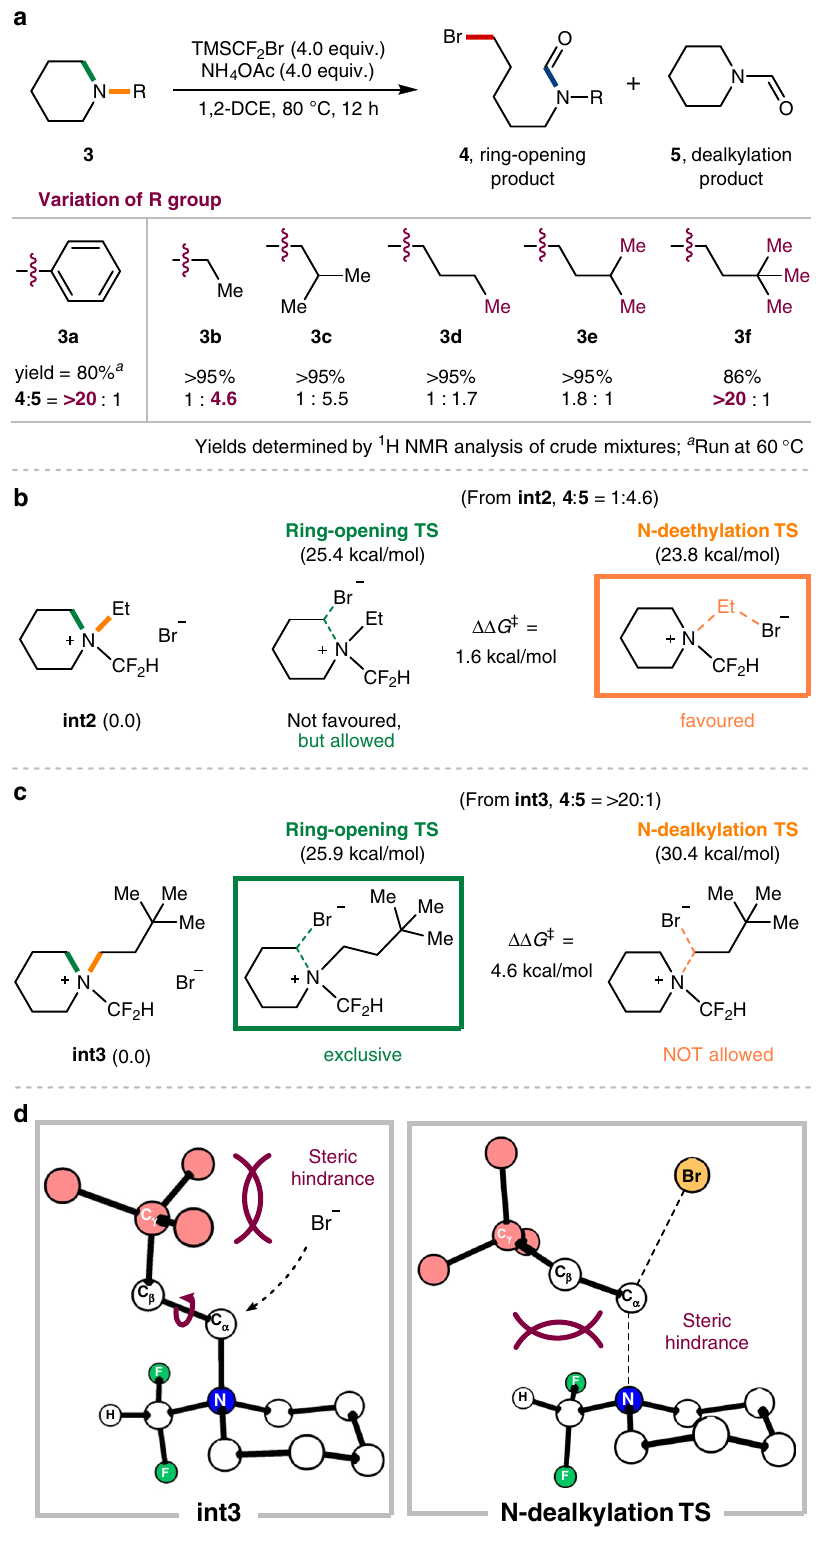
Fig. 5 Application to 6-membered cyclic amines and DFT calculations for the elucidation of the observed selectivity. a In fl uence of R group on the site- selectivity in 6-membered rings. b Competitive reaction energy pro fi les of N -dealkylation and ring-opening pathways of N -ethyl salt int2 . c Competitive reaction energy pro fi les of N -neohexyl salt int3 . d Structural analysis for N -dealkylation of int3